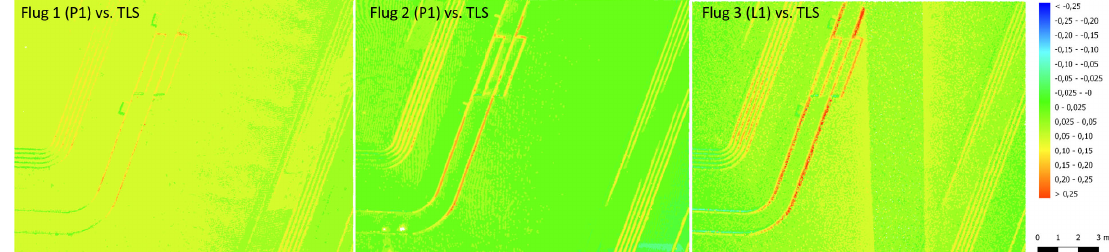
Figure 11 . Comparison of point clouds to TLS (reference) for UAV flights 1, 2 and 3 on test area 1.